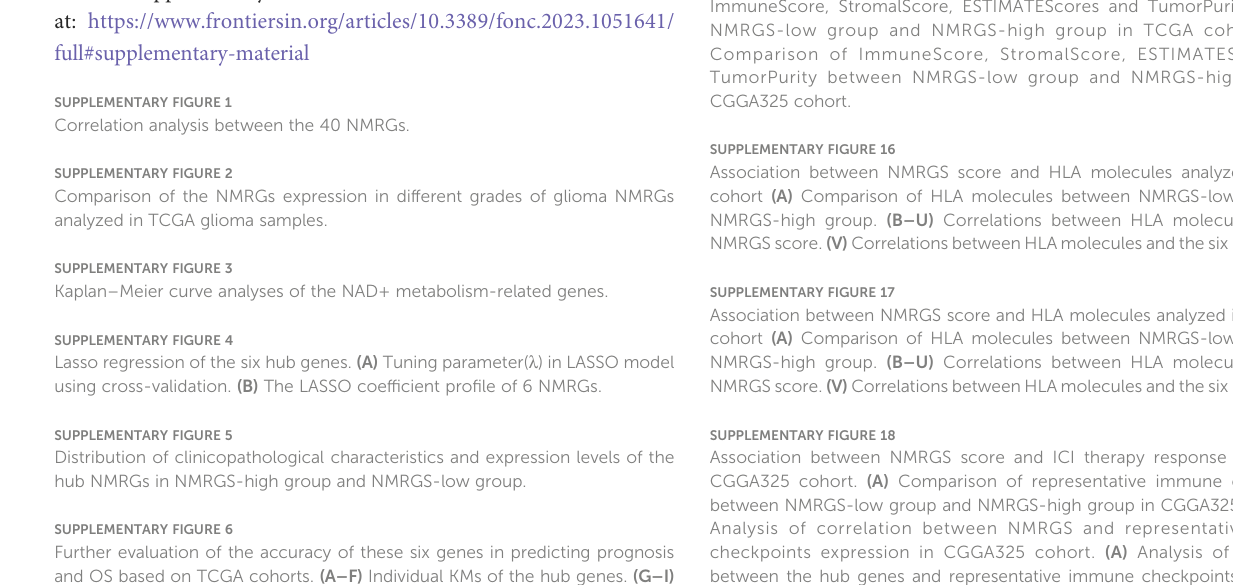
SUPPLEMENTARY FIGURE 7 KM analysis in different subgroups based on clinicopathological characteristics. SUPPLEMENTARY FIGURE 8 Patients fraction in different clinicopathological subgroups in CGGA693 cohort. SUPPLEMENTARY FIGURE 9 Patients fraction in different clinicopathological subgroups in TCGA cohort. SUPPLEMENTARY FIGURE 10 Patients fraction in different clinicopathological subgroups in CGGA325 cohort.